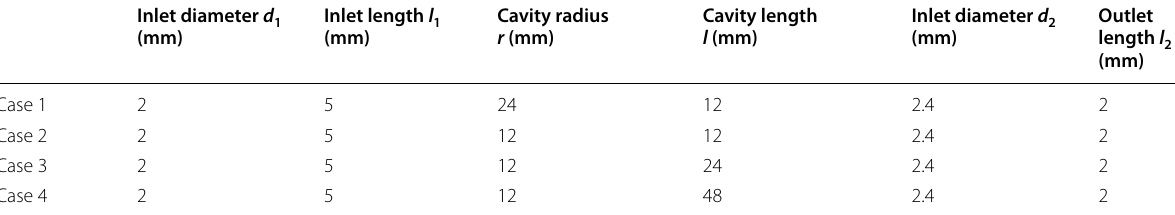
Table 1 Specifications of upstream